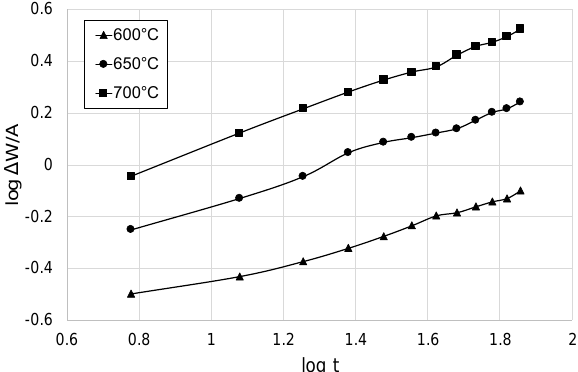
Figure 4. Graph showing the dependence of log ∆ W / A on log t.